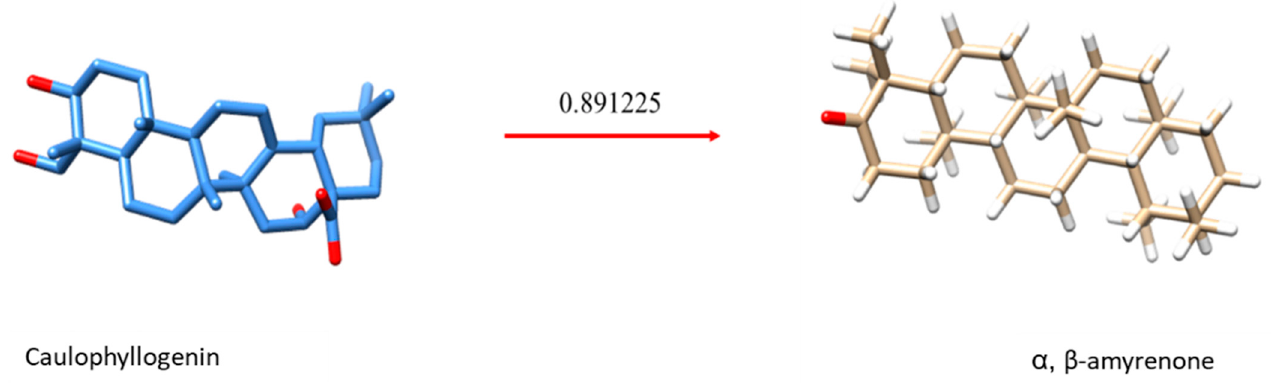
Figure 2. Similarity between the caulophyllogenin and α , β -amyrenone triterpenes. Table 2. Ligands with greater structural similarity to the binary mixture of α , β -amyrenone.